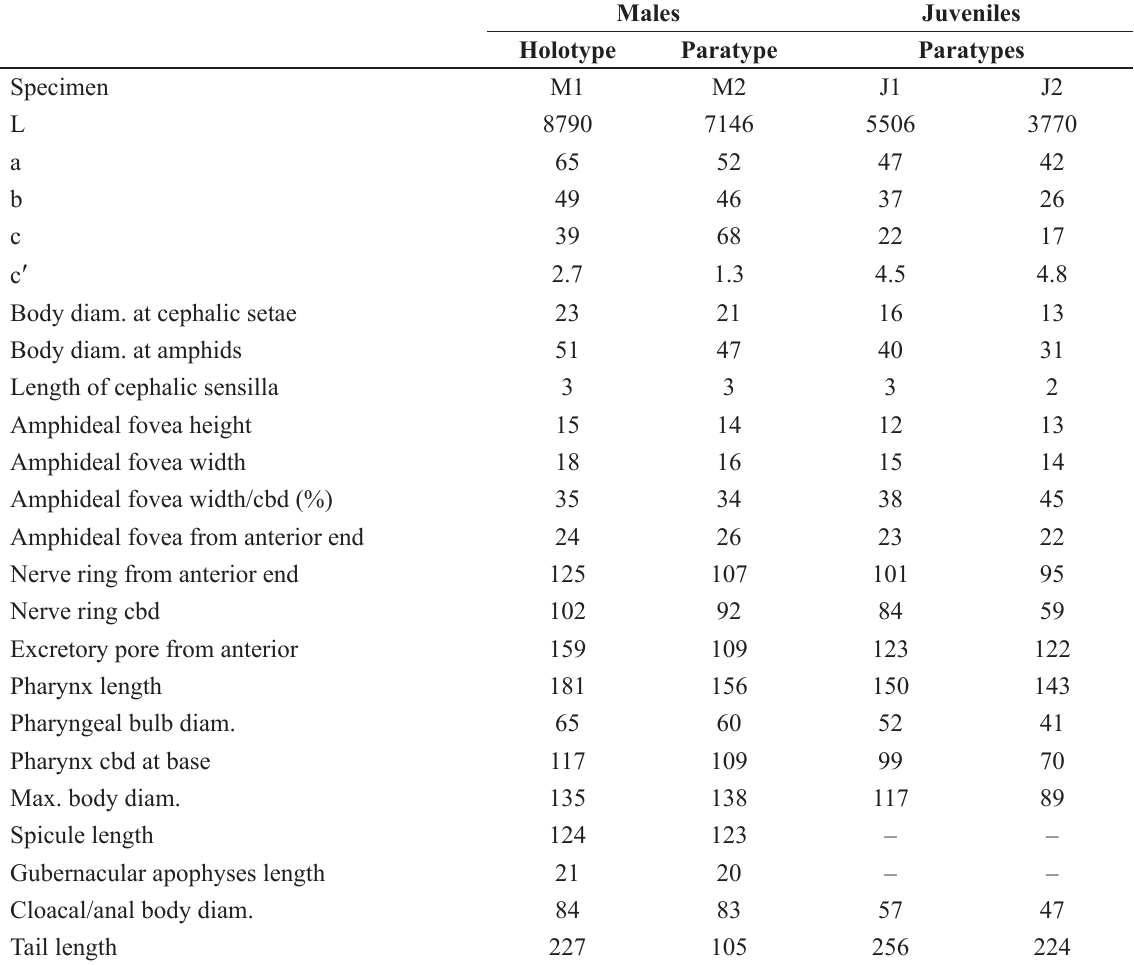
Table 4. Morphometrics (µm) of Aulostomonema abyssum gen. et sp. nov. Abbeviations: a = body length/maximum body diameter; b = body length/pharynx length; c = body length/tail length; cʹ = tail length/anal or cloacal body diameter; cbd = corresponding body diameter; L = total body length; V = vulva distance from anterior end of body; %V = V/total body length ×